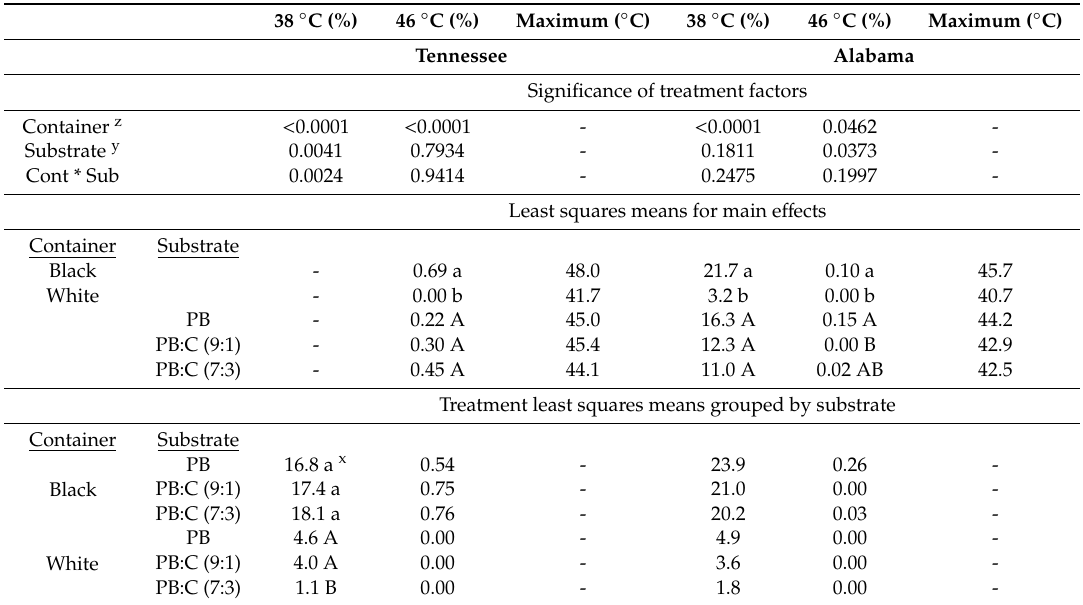
Table 5. Percent of time ( n = 3) root zone temperature (RZT) remained above critical thresholds (38 ◦ C and 46 ◦ C) and maximum RZT during daylight hours for “Green Giant” arborvitae grown in di ff erent types of containers and substrates in Tennessee (McMinnville) and Alabama (Mobile).